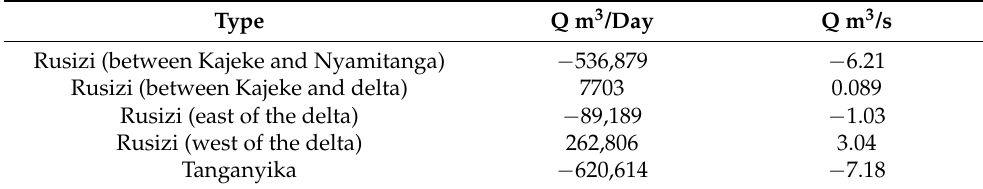
Table 6. Model outflows ( − ) and inflows (+) through the different portions of the Rusizi River and Lake Tanganyika represented in the